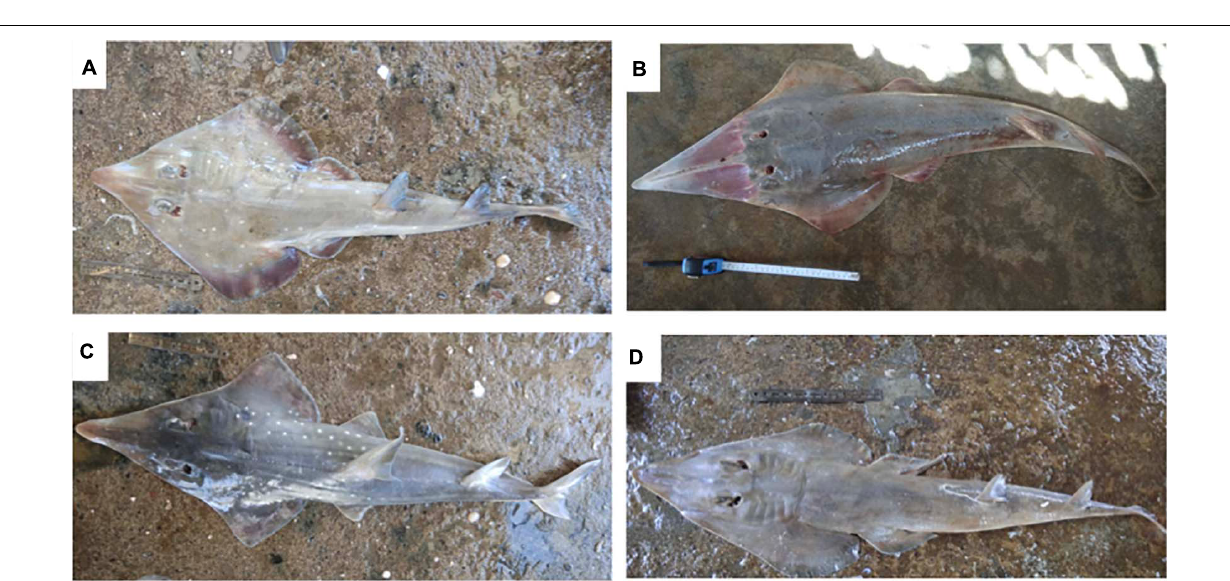
Frontiers in Marine Science |